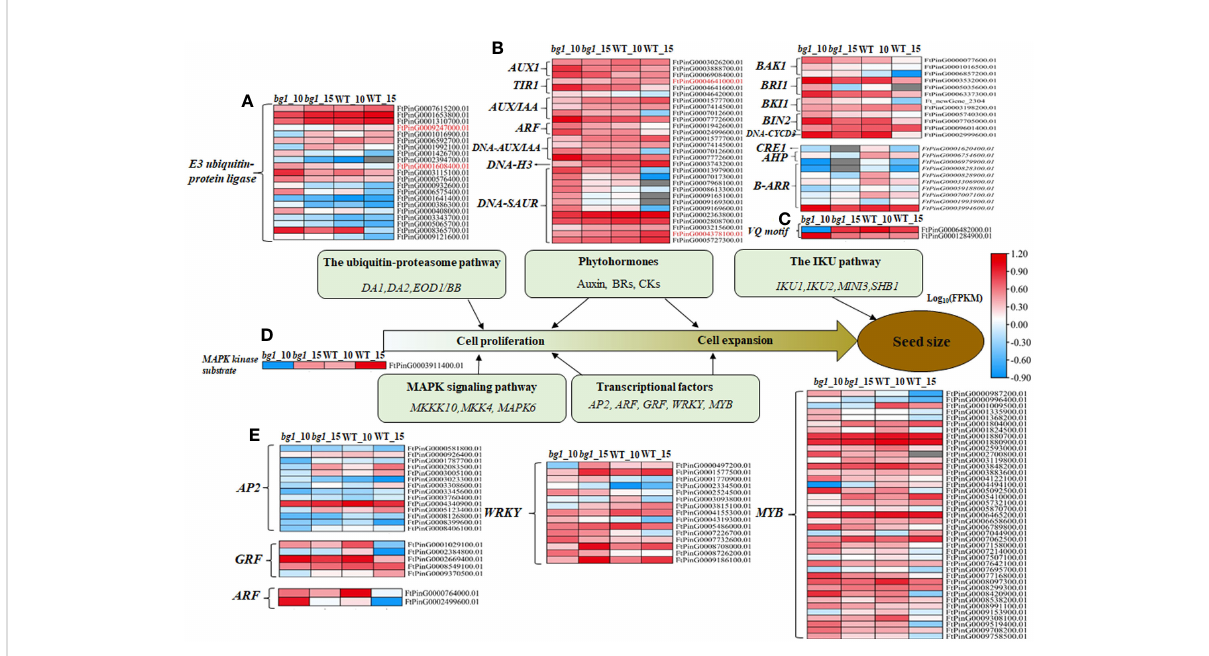
FIGURE 3 Heat map diagram of DEGs in the major signaling pathways of grain size control (Li and Li, 2016). (A) Ubiquitin-proteasome pathway. (B) Phytohormones (Auxin, Brs, CK). (C) IKU pathway. (D) MAPK signaling pathway. (E) Transcriptional